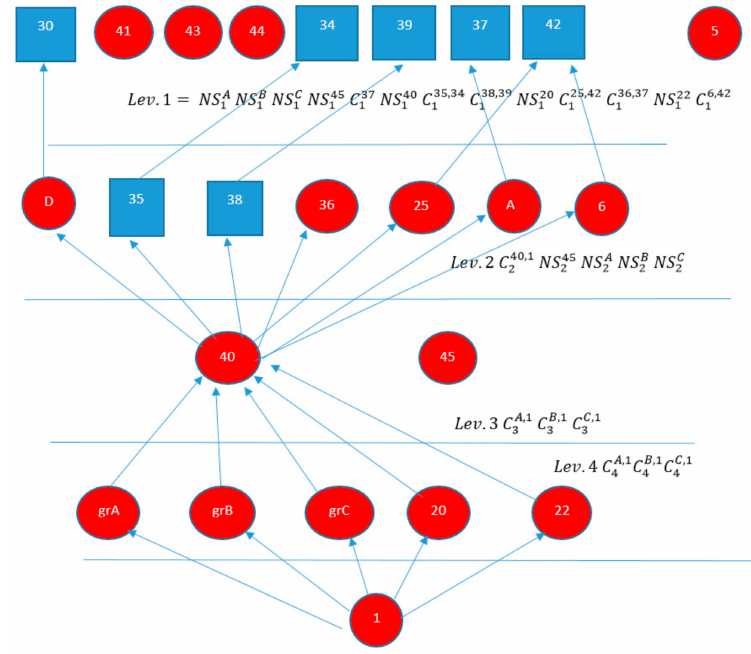
Figure 8. The DGCG used to analyze the